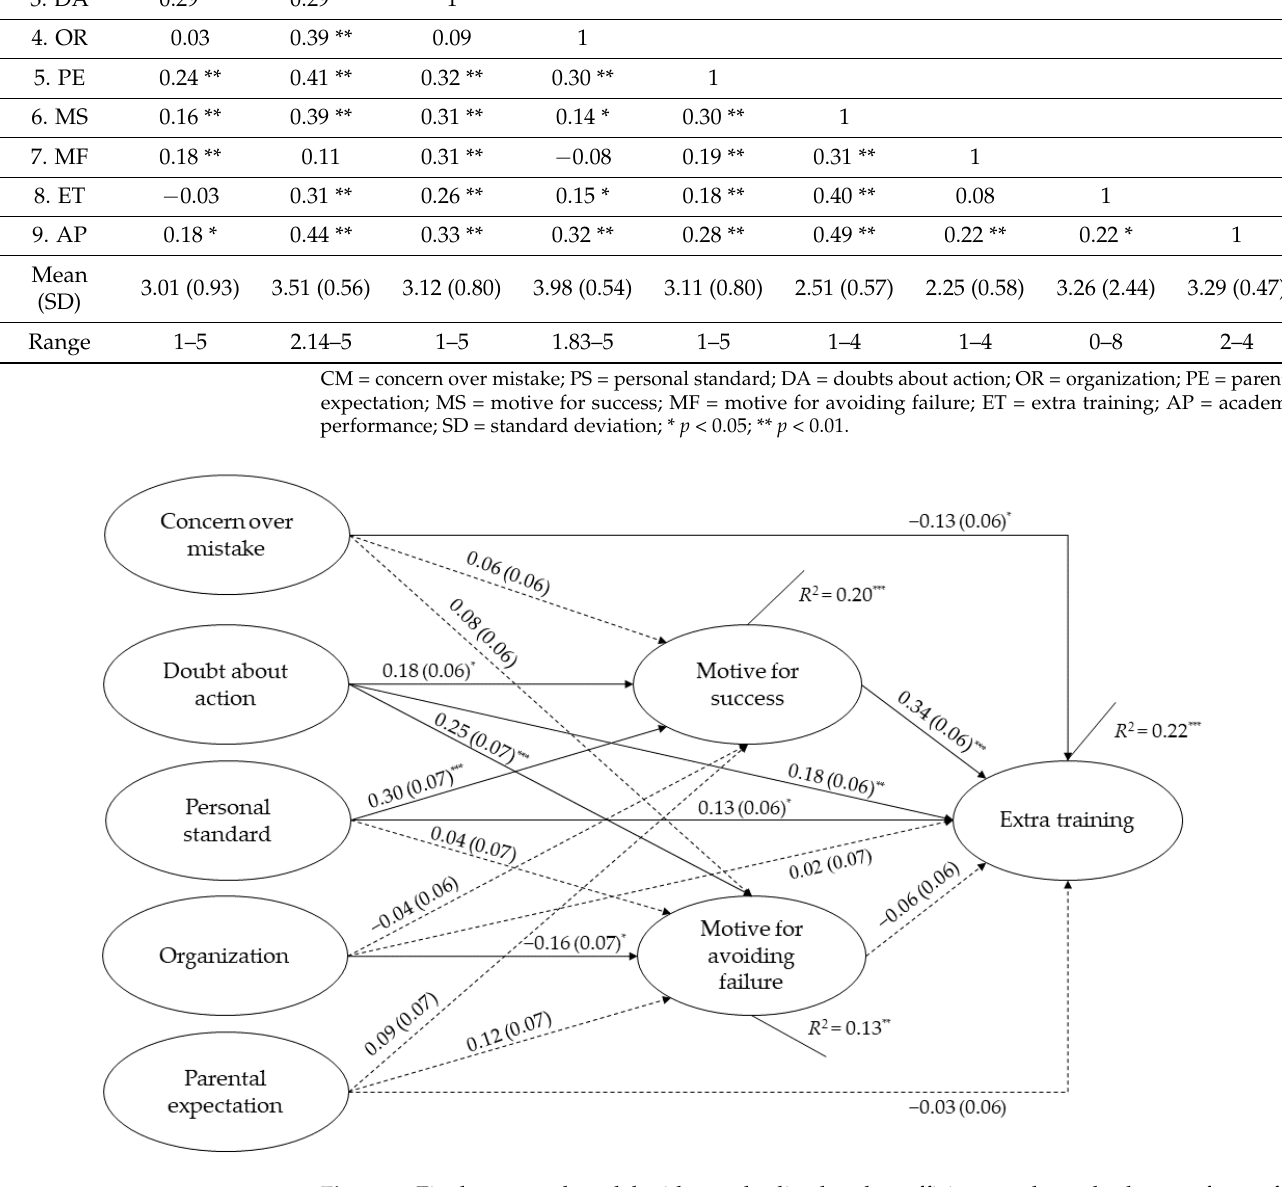
Figure 2. Final structural model with standardized path coefficients and standard errors for perfec- tionism, achievement motivation, and extra training ( n = 243). All the demographics were included as covariates. Significant path is indicated by solid line and non-significant path is indicated by dotted line. * p < 0.05, ** p < 0.01, *** p < 0.001.